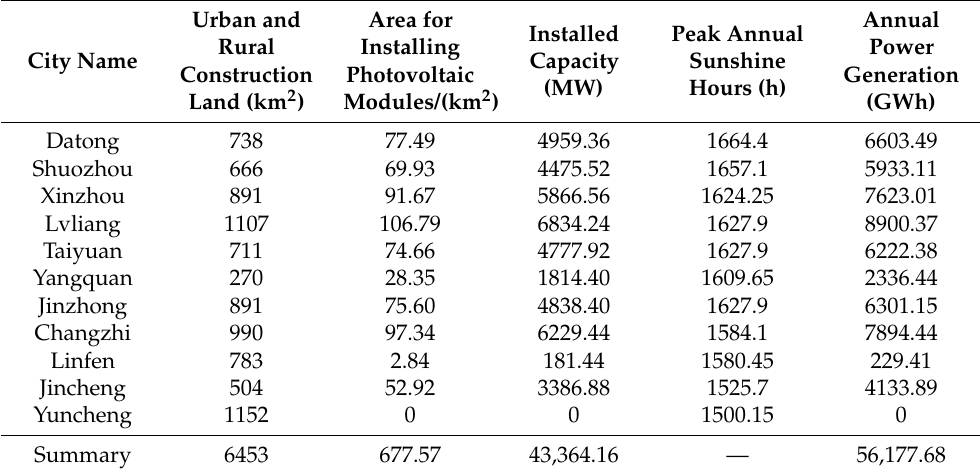
Table 6. Statistics of distributed photovoltaic installed capacity and annual power generation potential in suitable areas of Shanxi province.